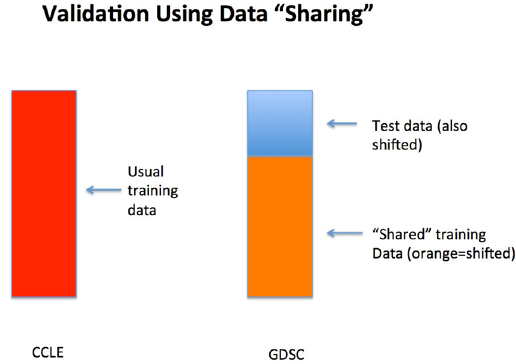
Figure 1. Schematic of data sharing for the combined GDSC-CCLE